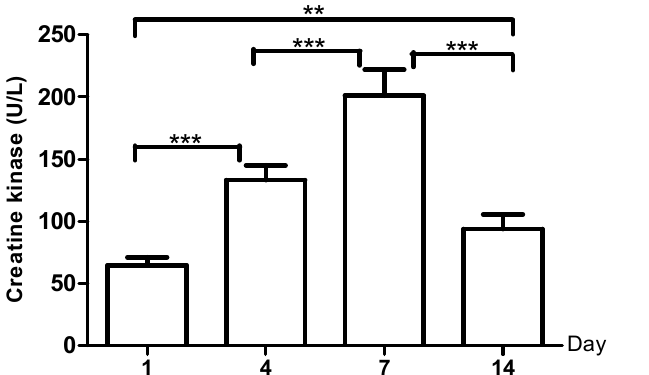
Figure 4. Creatine kinase levels during the micro-cycle, **: p -value < 0.01, ***: p -value < 0.001.